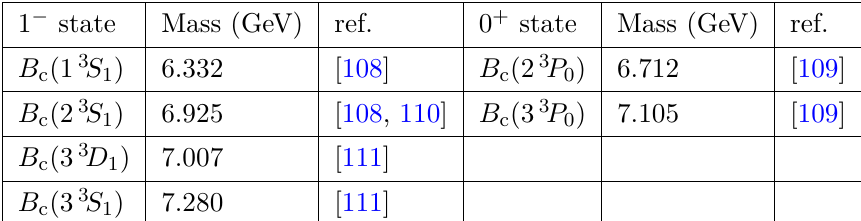
Table 2 . Relevant scalar ( 0 + ) and vector ( 1 − ) B c masses. Note that the B c (3 3 S 1 ) state is above the threshold and therefore does not enter the Blaschke factor for our